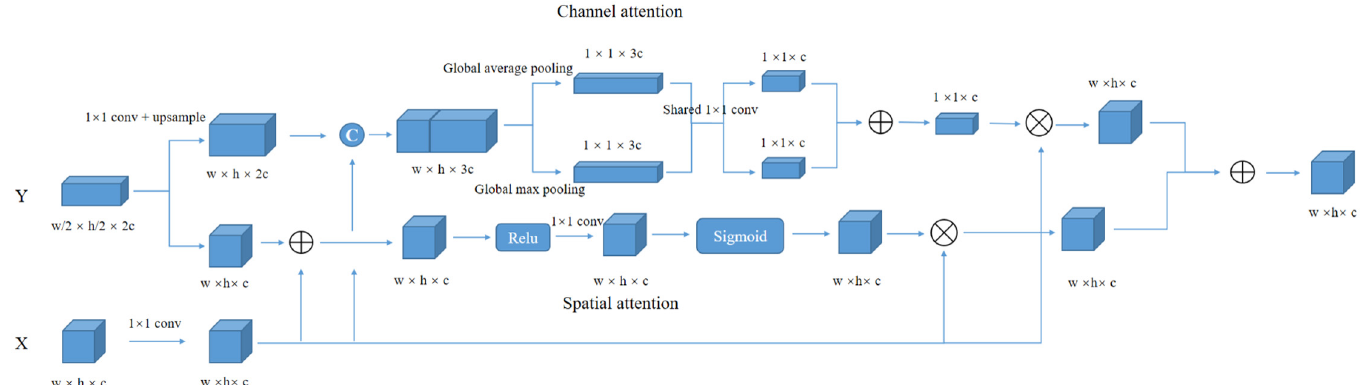
Fig 6. Illustration of the proposed attention module. It is composed of a spatial attention module and a channel attention module, and make the network focus on the most relevant regions and channels.